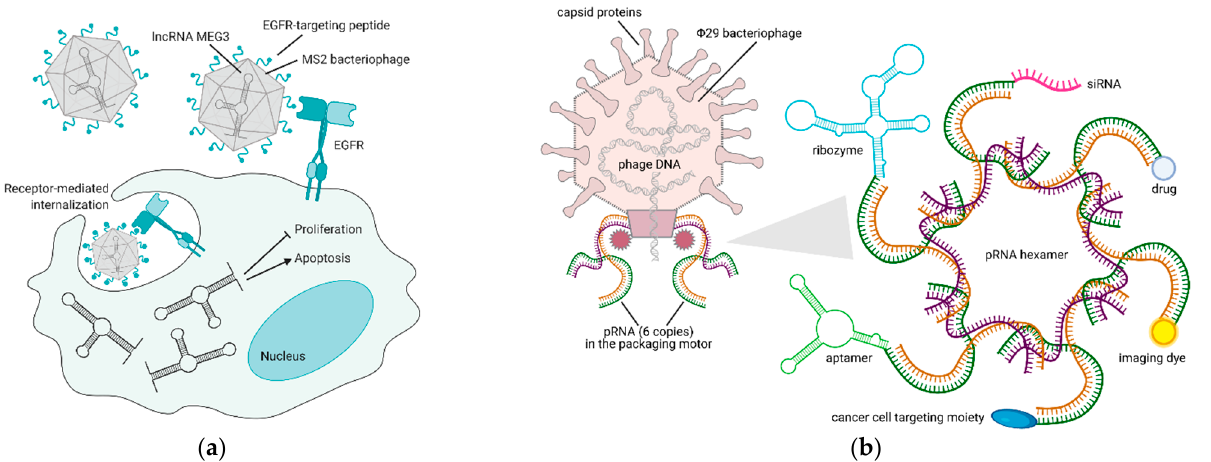
Figure 3. Bacteriophage-based platforms to deliver therapeutic and diagnostic agents via RNA technology. ( a ) Reintroduction of MEG3 lncRNA in cancer cells via an EGFR-targeted MS2 phage — upon binding to EGFR, the phage is internalized by endocytosis and releases MEG3, thus inducing apoptosis and inhibiting proliferation of cancer cells [63]. ( b ) VNPs derived from Φ 29 bacteriophage pRNA are suitable nanocarriers for the delivery of RNAs (aptamer, ribozyme, siRNA), small molecules (drug, dye), or proteins (targeting moiety) to cancer cells [64,65]. Figure created with BioRender.com.